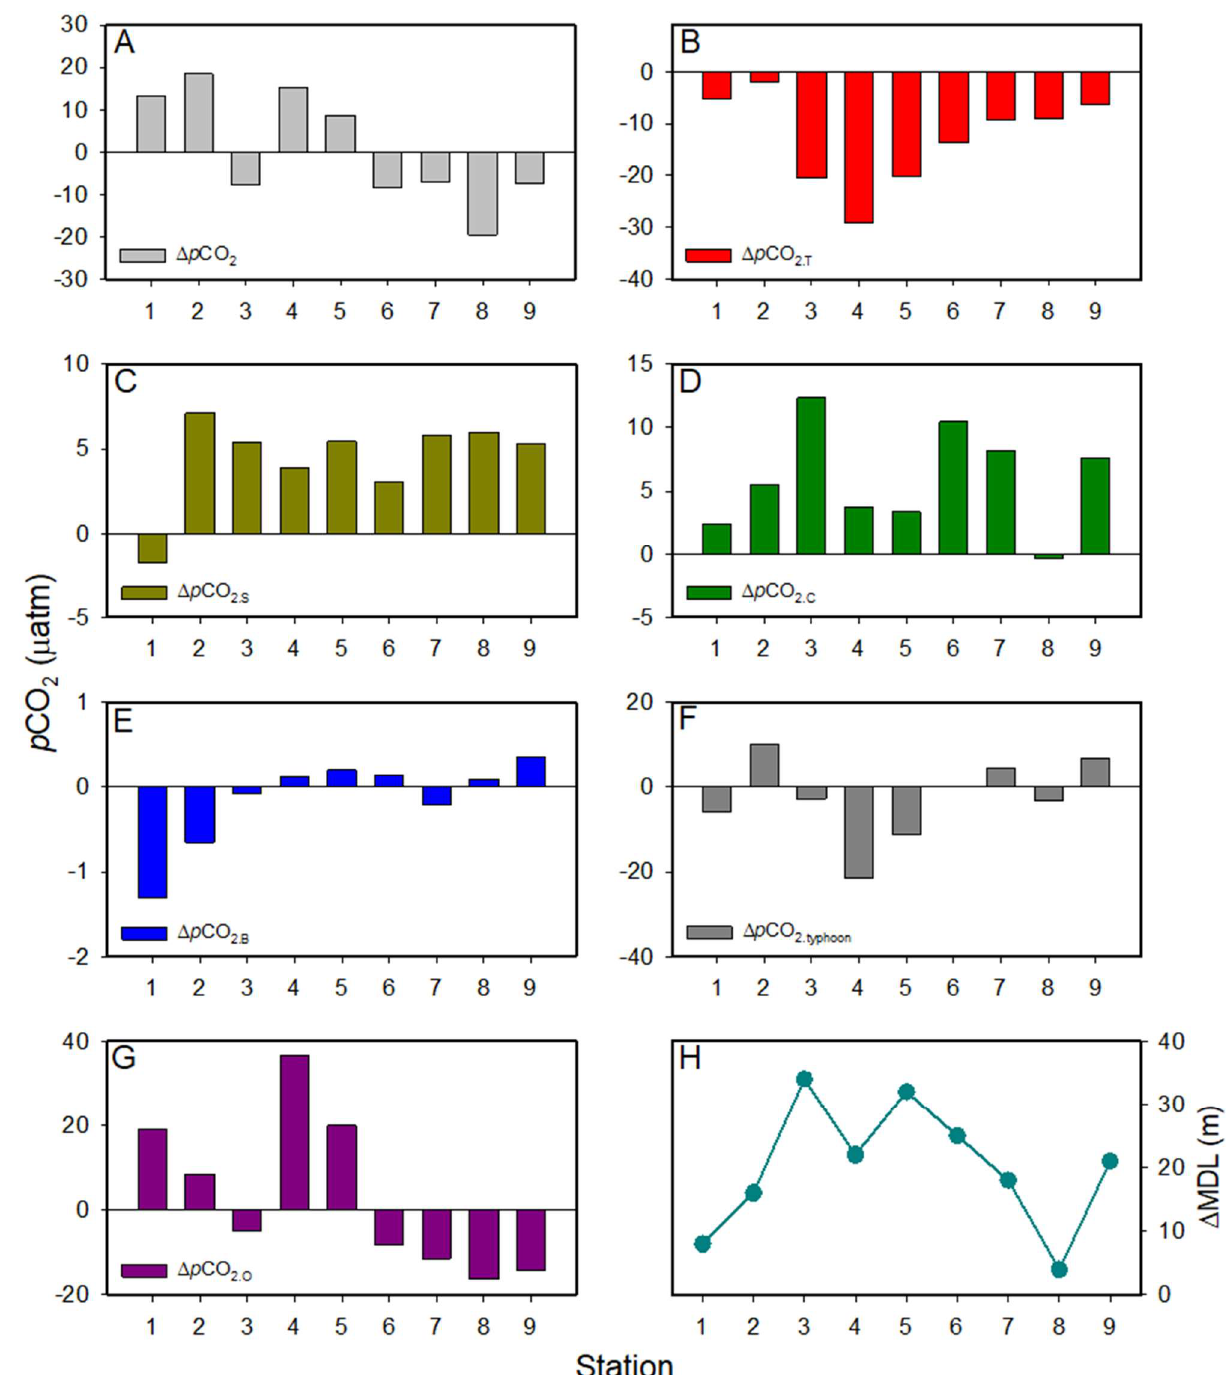
Figure 4. ( A ) The observed differences of p CO 2 (Δ p CO 2.Obs ) before and after the typhoon passage at the nine hydrological stations; ( B – G ), the contributions of temperature (Δ p CO 2 . T , ( B )), salinity (Δ p CO 2.S , ( C )), dissolved inorganic carbon/total alkalinity (DIC/TA) input (Δ p CO 2.C , ( D )), and nutrient input (i.e., biological production, Δ p CO 2.B , ( E ) to the observed Δ p CO 2 ; ( F ) the sum of the contributions of the typhoon-related effects (Δ p CO 2.typhoon = Δ p CO 2.T + Δ p CO 2.S + Δ p CO 2.C + Δ p CO 2 . B ); ( G ) the contribution of non-typhoon-related effect to the observed Δ p CO 2 ; and ( H ) the variations of mixed-layer depth (ΔMLD) before and after the typhoon passage.